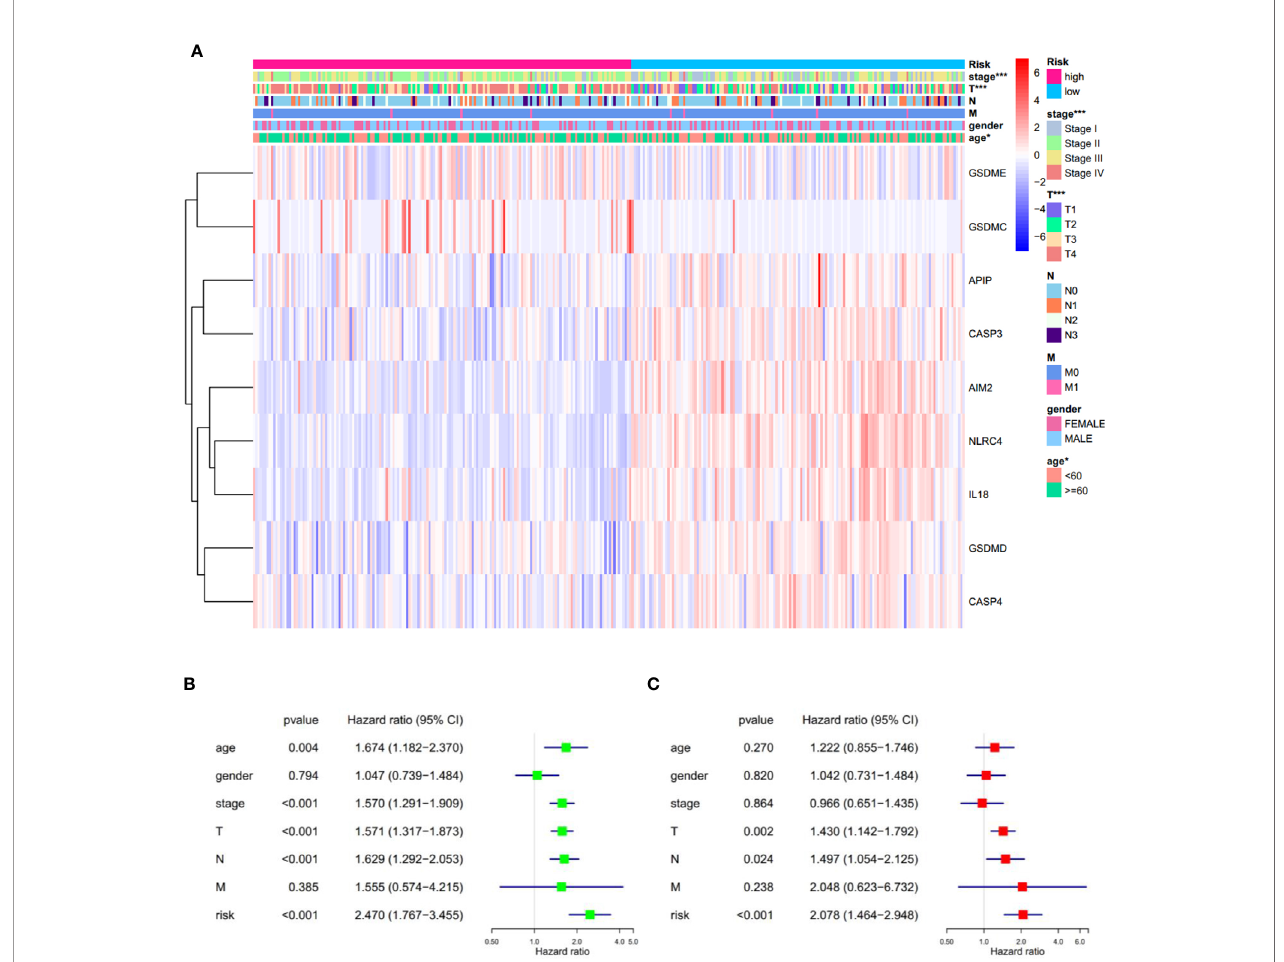
FIGURE 6 | Univariate and multivariate Cox regression analyses for the risk score. (A) Heatmap and the clinical characters of low- and high-risk subgroups (T, N, and M are the tumor node metastasis classi fi cation) (* p < 0.05, *** p < 0.001). (B, C) Univariate (B) and multivariate (C) Cox regression analyses showing the signi fi cance and hazard ratio values of risk score and clinical characters. CI, con fi dence